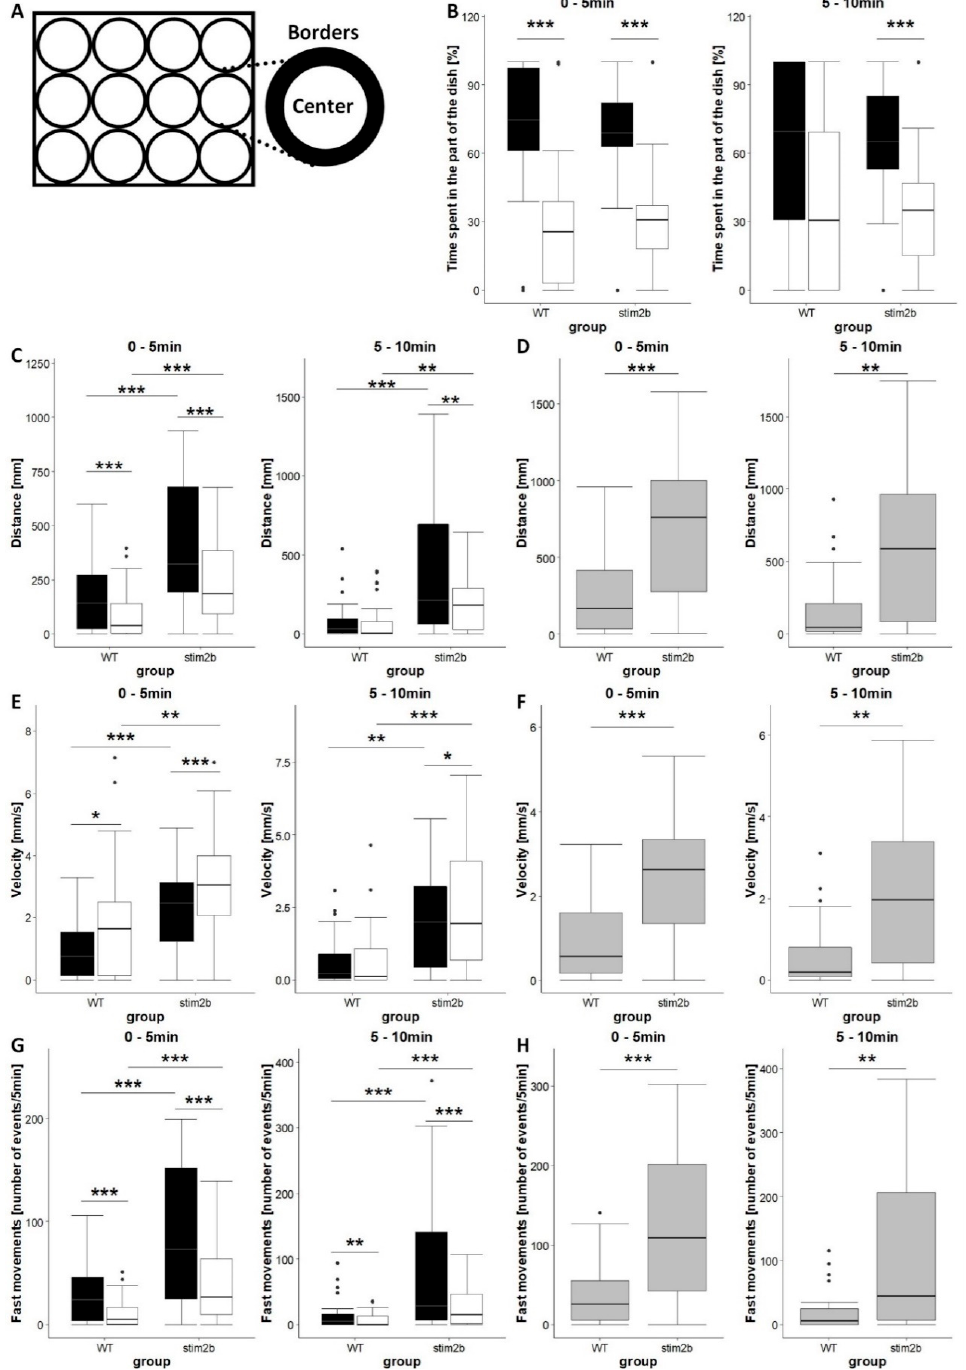
Figure 3. Increases in mobility and thigmotaxis in stim2b − / − larvae in the open field test. ( A ) Schematic diagram of the 12-well plates that were used in the experiments, showing a division into borders and central areas. ( B , C , E , G ) Boxplots of the time spent in each area (black in the border; white in center), distance traveled, velocity, and the frequency of fast movements in each part in WT and stim2b − / − larvae. ( D , F , H ) Boxplots of distance traveled, velocity, and the frequency of fast movements in WT and stim2b − / − larvae in both the border and central areas of the well combined. ( G , H ) Movements were considered fast movements when velocity was higher than 20 mm/s. * p < 0.05, ** p < 0.01, *** p < 0.001, border vs. center for each genotype (paired t -test) or mutant vs. WT (Wilcoxon rank-sum test). Number of larvae: n = 32 WT, n = 33 stim2b − / − . Number of experiments: